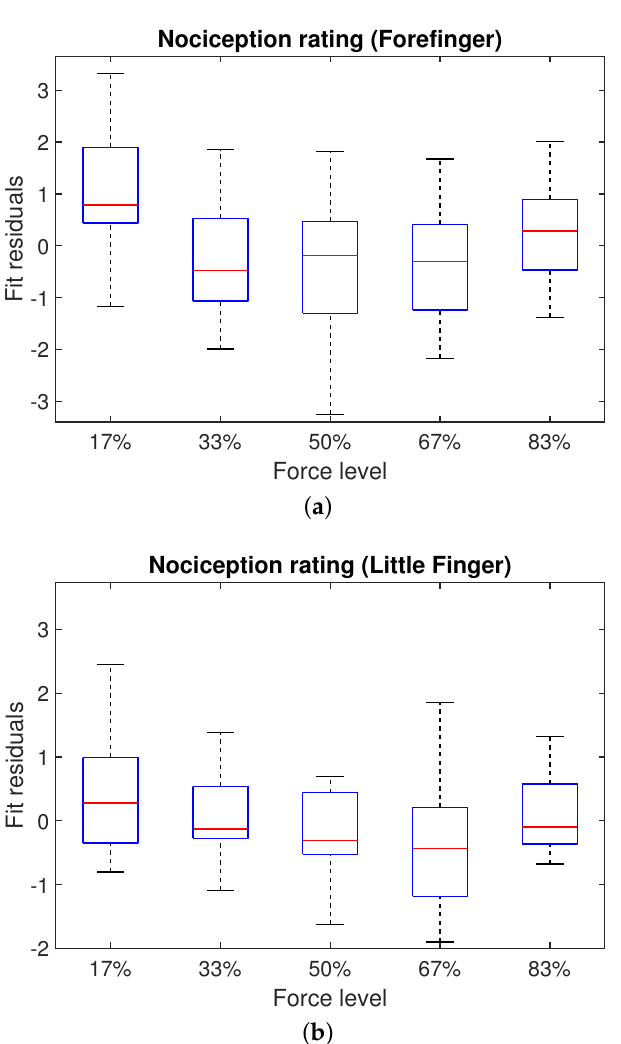
Figure 6. Box plots of the residuals of the fitting of the nociception experiments (ten fits) on ( a ) forefinger and ( b ) little